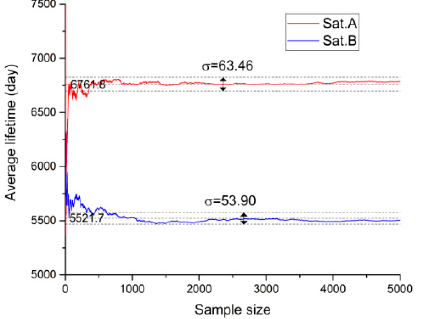
Figure 10. Convergence range of the samples.